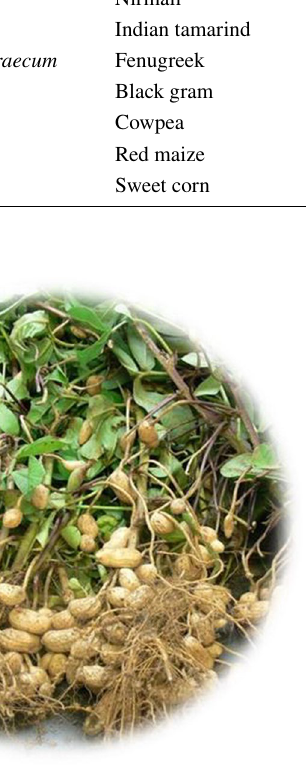
Fig. 5 Arachis hypogea plant seeds as a coagulant